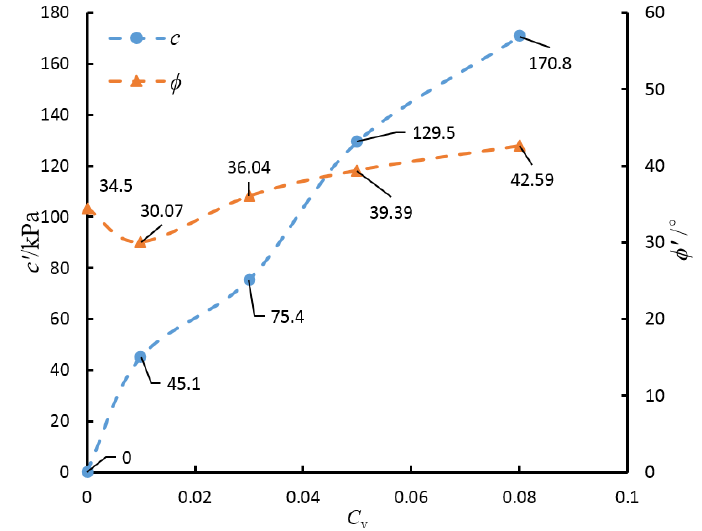
Figure 9. The relationship curves for C v and c ′ ( ϕ′ )